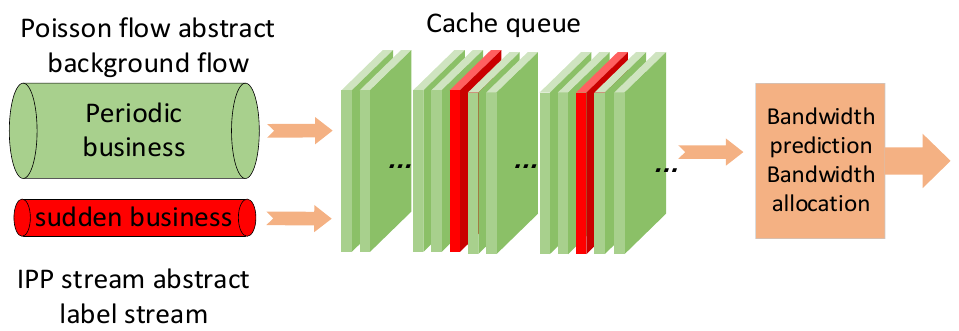
Figure 1. Convergence flow of intelligent power distribution and consumption communication service.